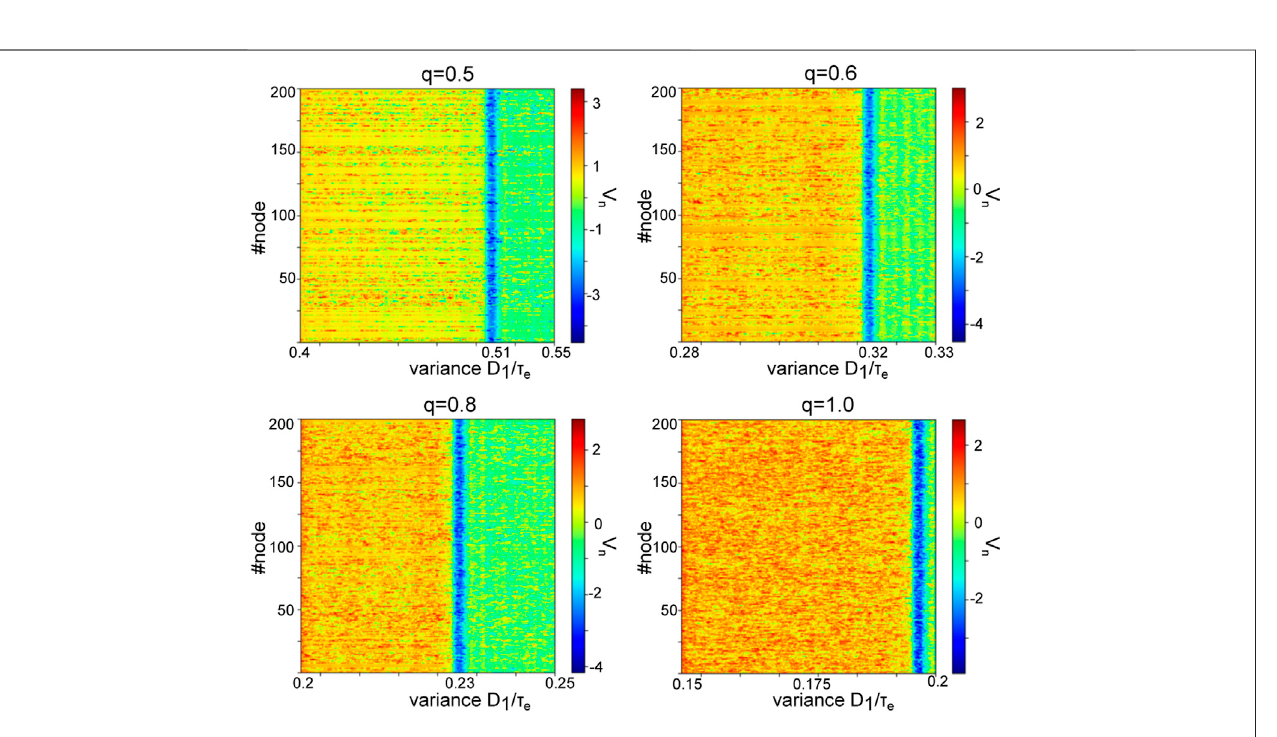
Frontiers in Applied Mathematics and Statistics |